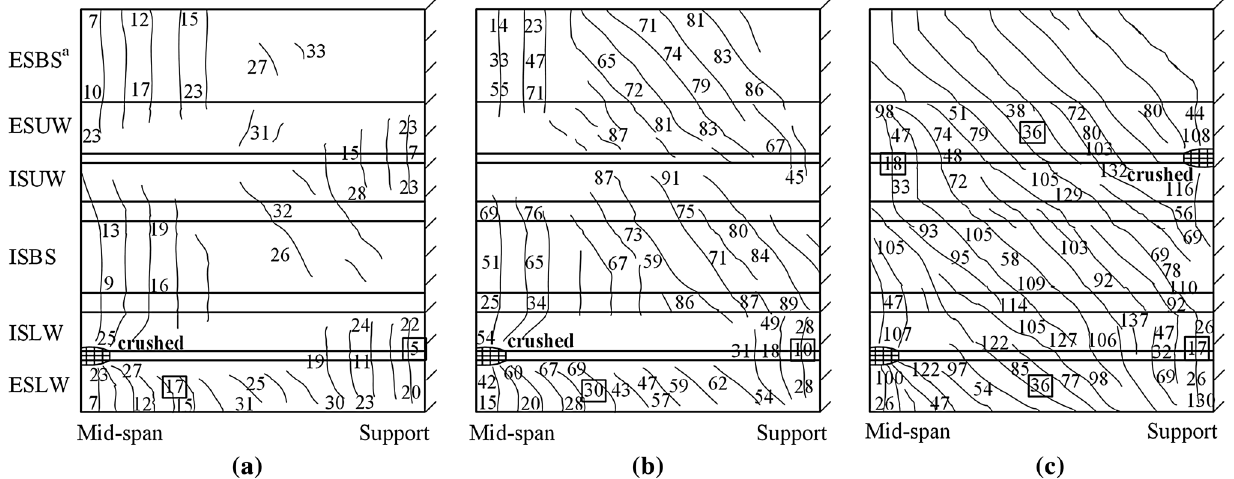
Fig. 5 Crack patterns of three beam specimens: a MEM-1:5, b MEM-1:1, and c MEM-1:0. a The ‘‘ESBS’’ means ‘‘External Surface of Bottom Slab’’, where the first two letters ‘‘ES’’ means ‘‘External Surface,’’ and the last two letters ‘‘BS’’ means ‘‘Bottom Slab.’’ As to other abbreviations, the first two letters ‘‘IS’’ means ‘‘Internal Surface,’’ the last two letters ‘‘LW’’ and ‘‘UW’’ mean ‘‘Loaded Web’’ and ‘‘Unloaded Web,’’ respectively.